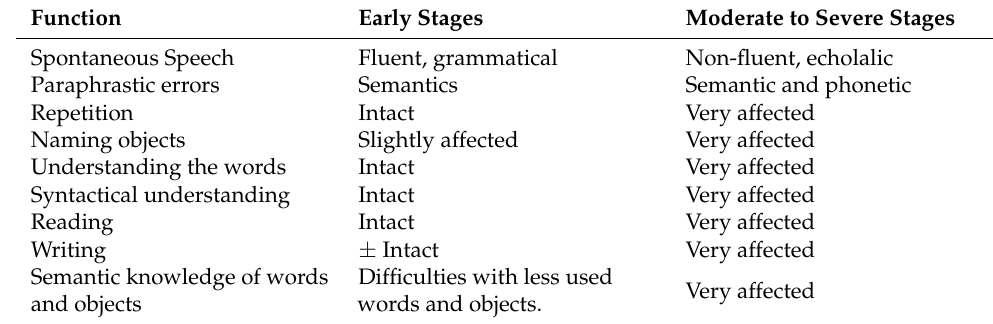
Table 1. Language changes in AD (adapted from Ferris and Farlow [18] and Greta et al.